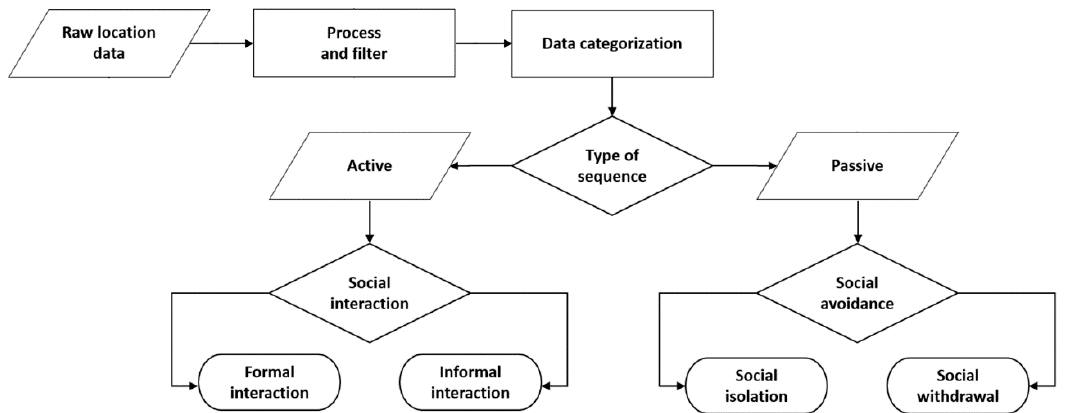
Figure 4. Schematic overview of social behaviour classification for the elderly residents.